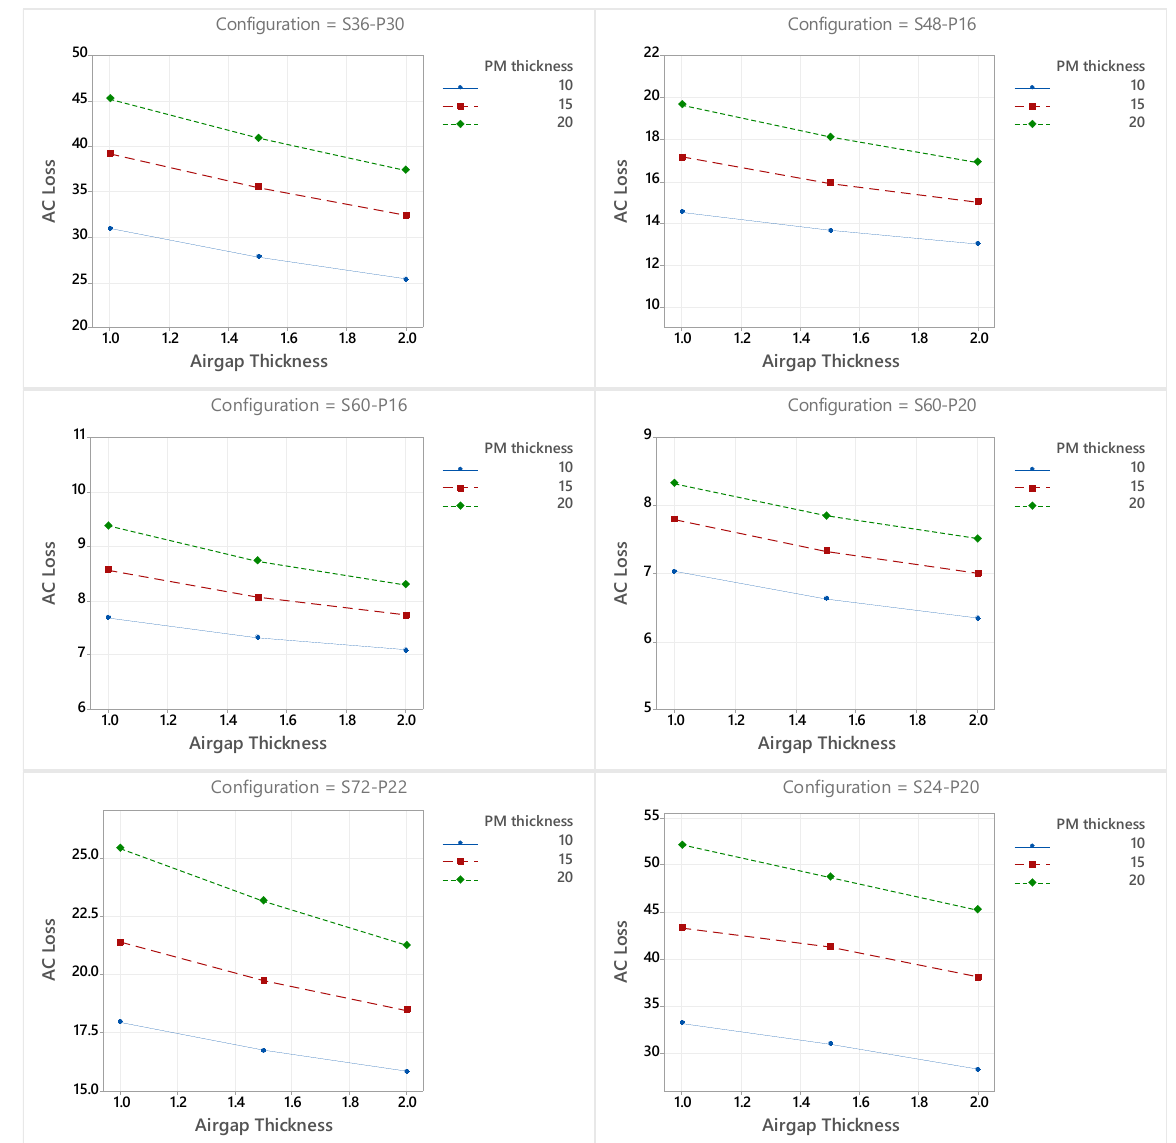
Figure 4. AC losses (kW) for the PM-to-airgap ratio study.